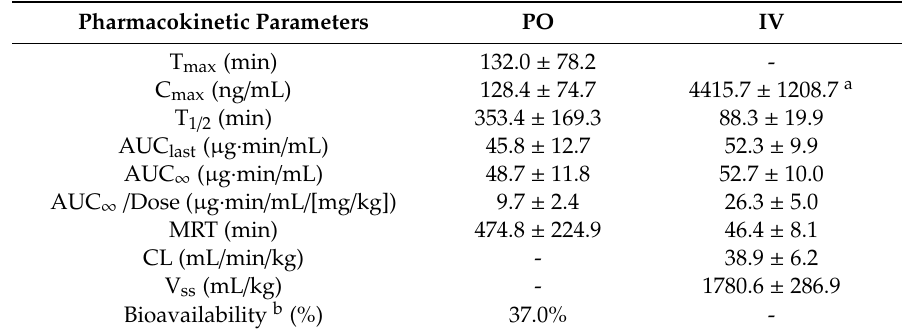
Figure 3. Mean plasma concentration vs. time profiles of KD025 after a single oral administration of 5 mg/kg KD025 (n = 5) (black circle) and an intravenous injection of 2 mg/kg KD025 (n = 5) (white circle) to rats. Results are presented as means ± standard deviations. Table 4. Pharmacokinetic parameters of KD025 after single oral (5 mg/kg, n = 5) and intravenous (2 mg/kg, n = 5) administrations to rats (mean ± standard deviations).